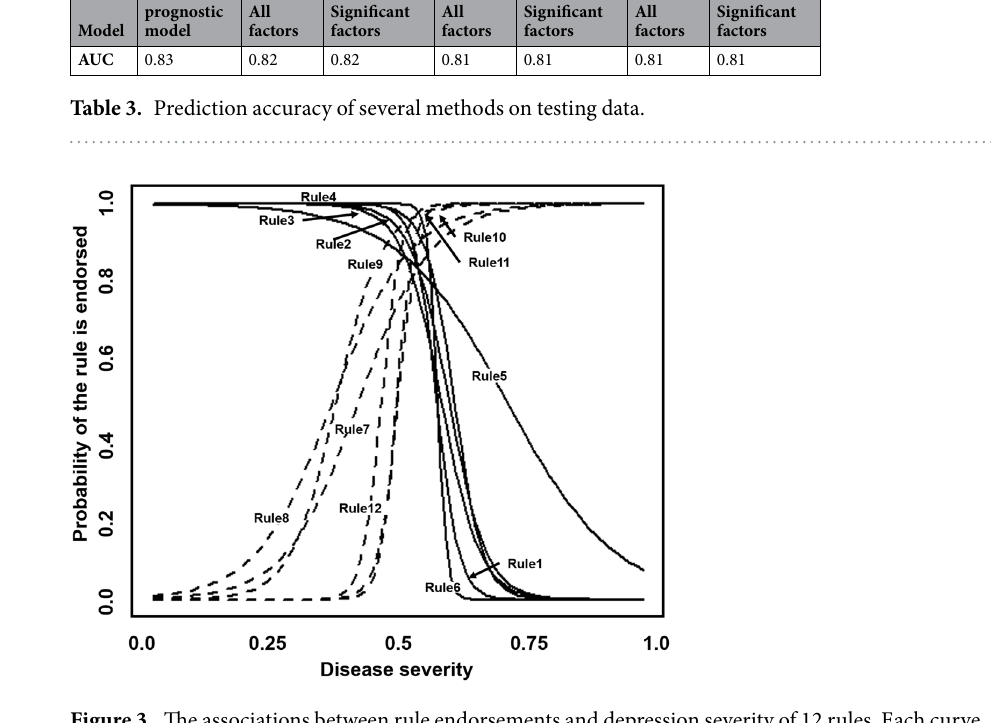
Figure 3. The associations between rule endorsements and depression severity of 12 rules. Each curve represents the probabilities of endorsing a rule under various depression severity. The increasing risk rules are plotted in dash lines and the decreasing risk rules are plotted in solid lines.